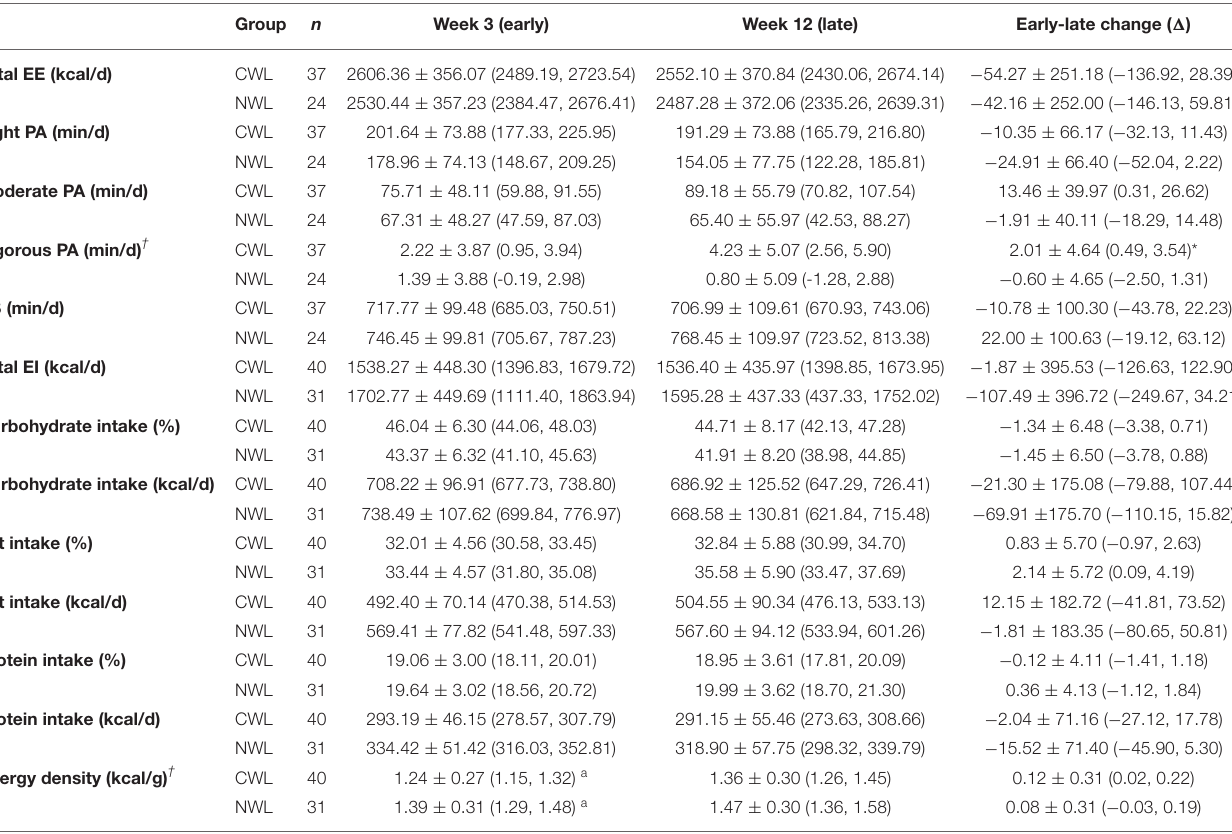
TABLE 4 | Change in energy expenditure (EE), free-living physical activity [from light to vigorous physical activity (PA)], sedentary behavior (SB), energy intake, and macronutrient composition between week 3 and week